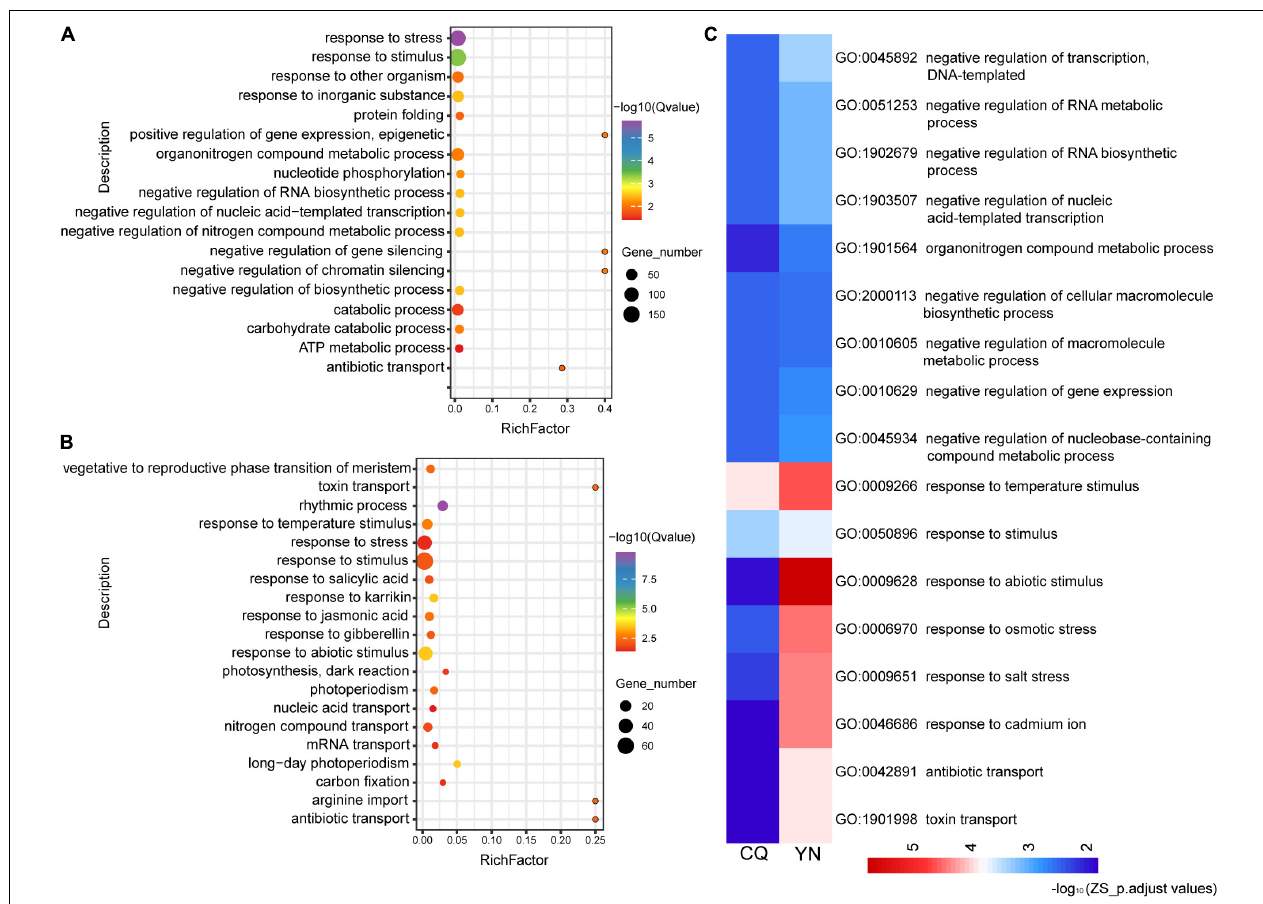
FIGURE 2 | GO functional classification of the ZS DEGs from high- and low-HI accessions at CQ and YN. (A) ZS_CQ_High vs. Low. (B) ZS_YN_High vs. Low. (C) Common GO terms shared by CQ and YN varieties. The color bars under the figures represent -log 10 ( p .adjust